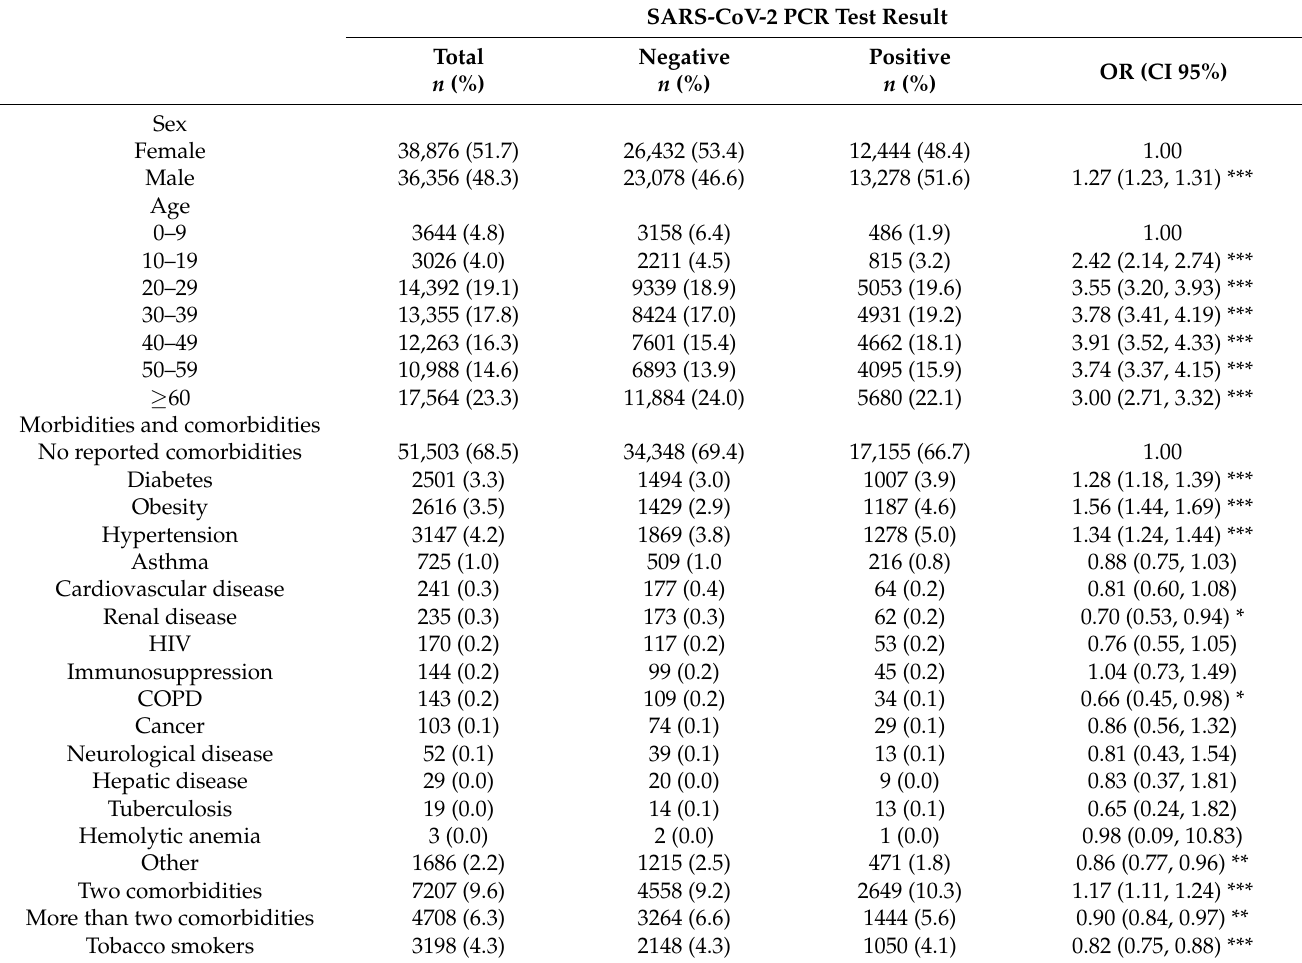
Table 2. Associated factors with SARS-CoV-2 infection ( n =